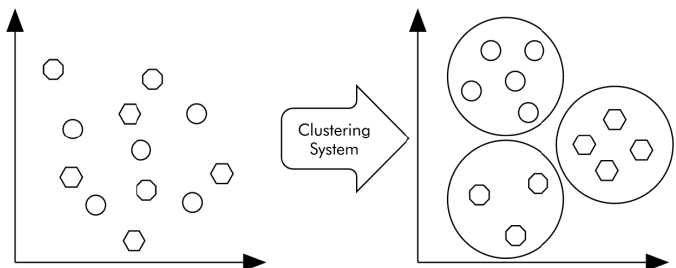
Figure 18. Clustering algorithm (Adapted from [27]).